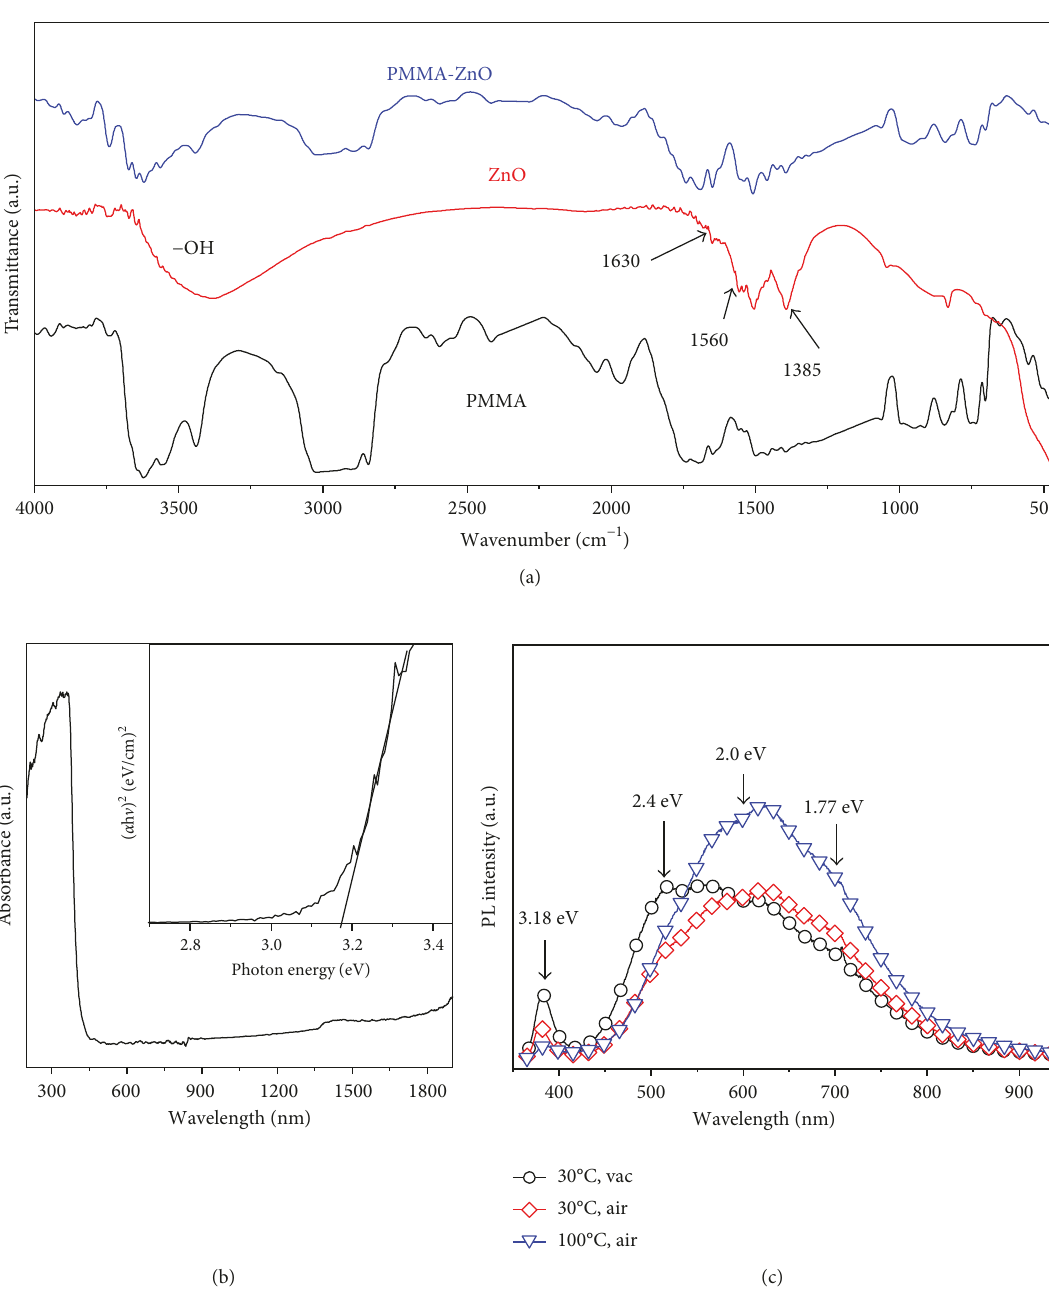
Figure 3: (a) FT-IR spectra and (b) UV-absorption. Inset: Tauc plot determining the bandgap of ZnO. (c) PL spectra of ZnO samples with different postdrying conditions ( λ ex �